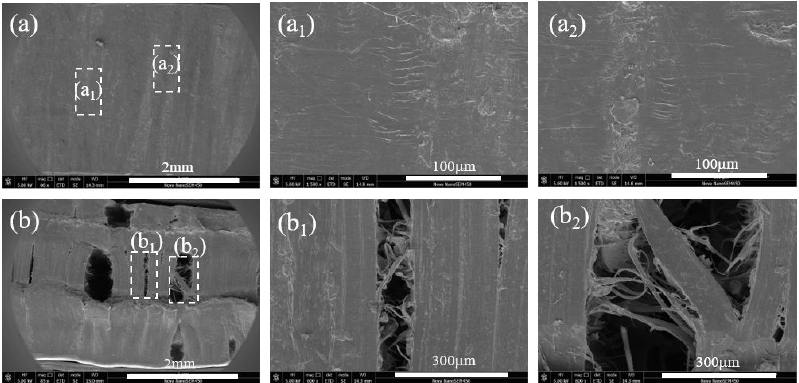
Figure 8. The SEM images of morphology of sample after suffering SCG process. ( a ): V 1 , ( b ): V 2 . ( a 1 ), ( a 1 ),( a 2 )and( b 1 ), ( b 2 )arethecorrespondingmagnifiedimagesin( a )and( b )respectively. Theobservation ( a 2 ) and ( b 1 ), ( b 2 ) are the corresponding magnified images in ( a ) and ( b ) respectively. The observation direction of SEM is the transverse direction (TD) shown in Figure 1. direction of SEM is the transverse direction (TD) shown in Figure